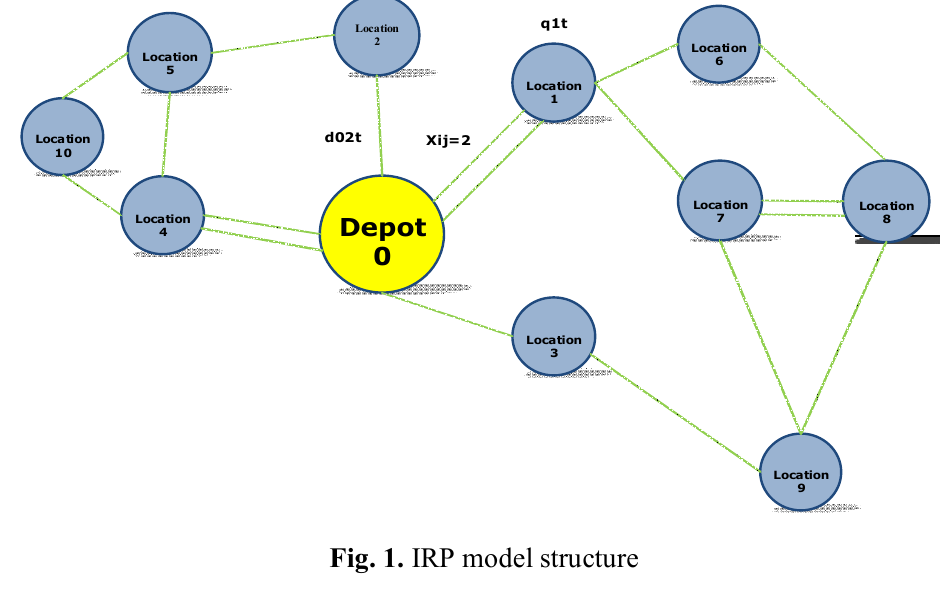
Fig. 1. IRP model